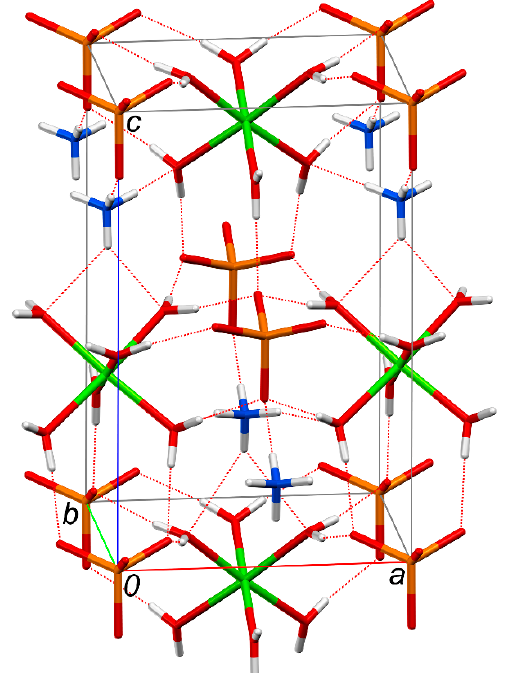
Figure 4. A fragment of molecular packing with the unit cell (with the coordinate system adopted in this study) showing the three-dimensional hydrogen-bond network marked with dotted lines. Table 2. Bond lengths, selected bond valences and bond angles for struvite.